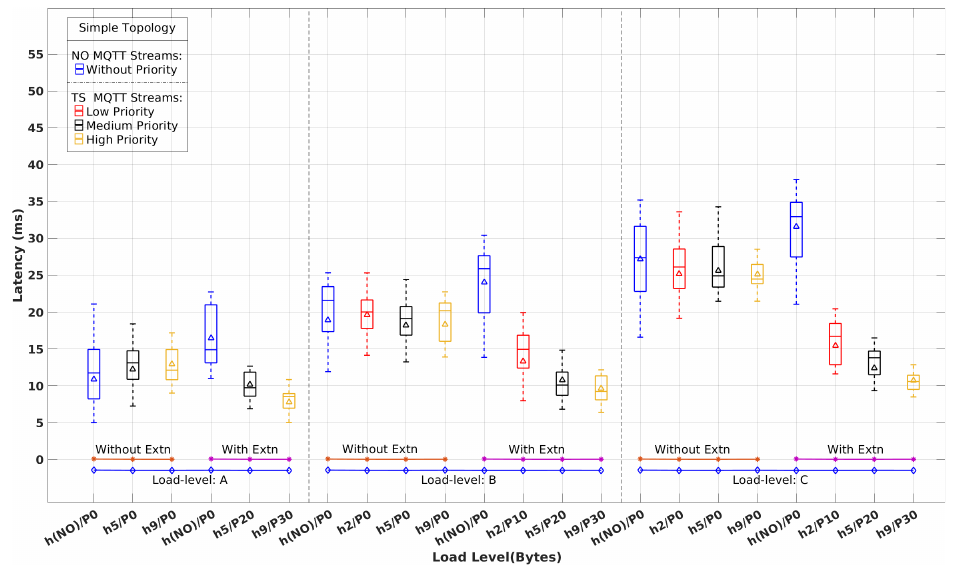
Figure 8. Latency of time-sensitive vs. normal MQTT flows with and without real-time extensions for the Simple topology and load levels A, B, and C.